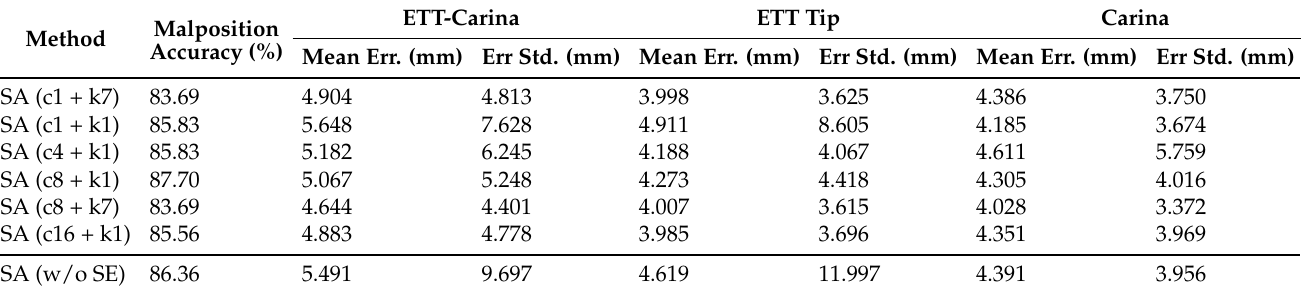
Table 16. The effect of channel, kernel and SE block of SA.